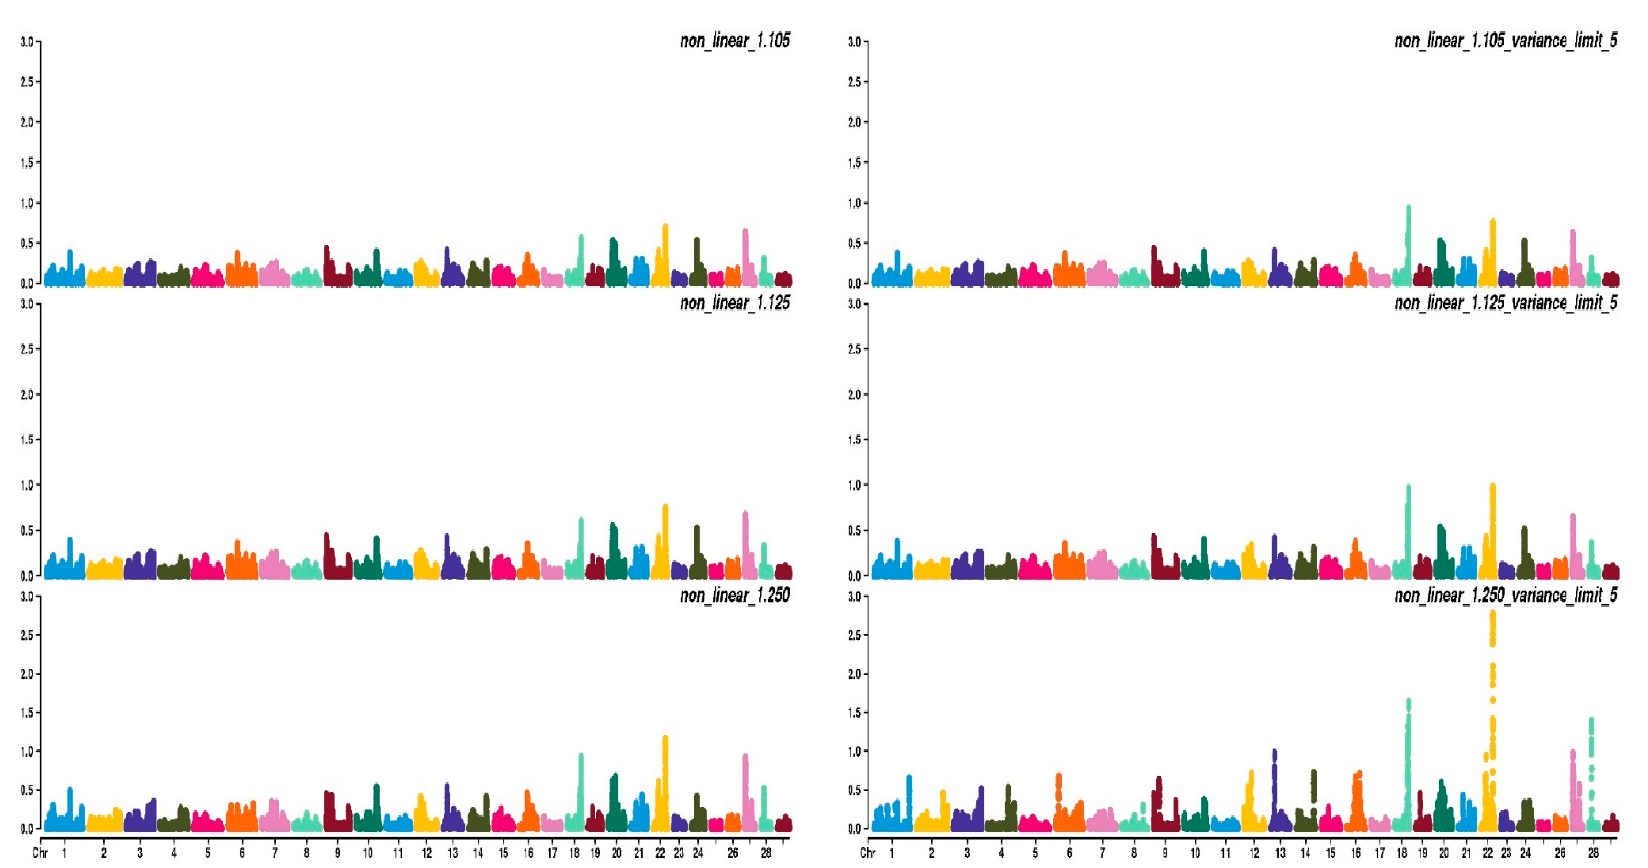
Figure 5. Manhattan plots for dressing percentage (DP) using different WssGBLUP strategies in iterations equal to 10; y-axes represent the percentage explained by each SNP. Variance explained was calculated with the sliding window approach.